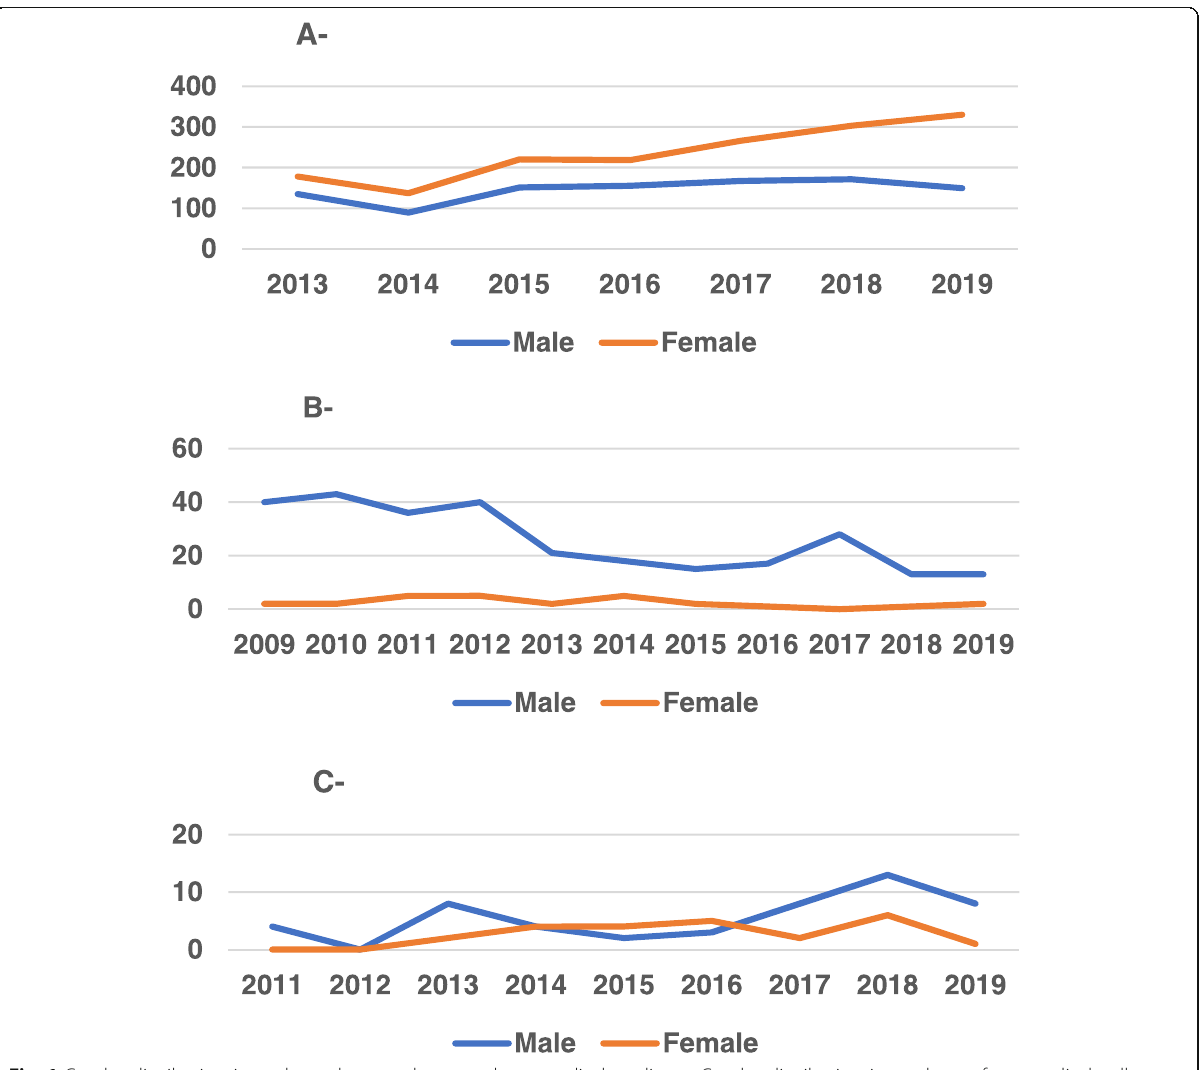
Fig. 1 Gender distribution in undergraduate and postgraduate medical studies. a Gender distribution in graduates from medical colleges 2013 – 2019. b Gender distribution in internal medicine fellowship graduates 2009 – 2019. c Gender distribution in echocardiography diploma graduates 2011 – 2019. Females represent the higher proportion among medical college graduates, yet females constitute only minority of internal medicine fellows. Females represent better proportion in echocardiography diploma due to more predictable working hours and being a less stressful specialty (data from Baghdad and Al-Nahrain Universities and Iraqi Board for